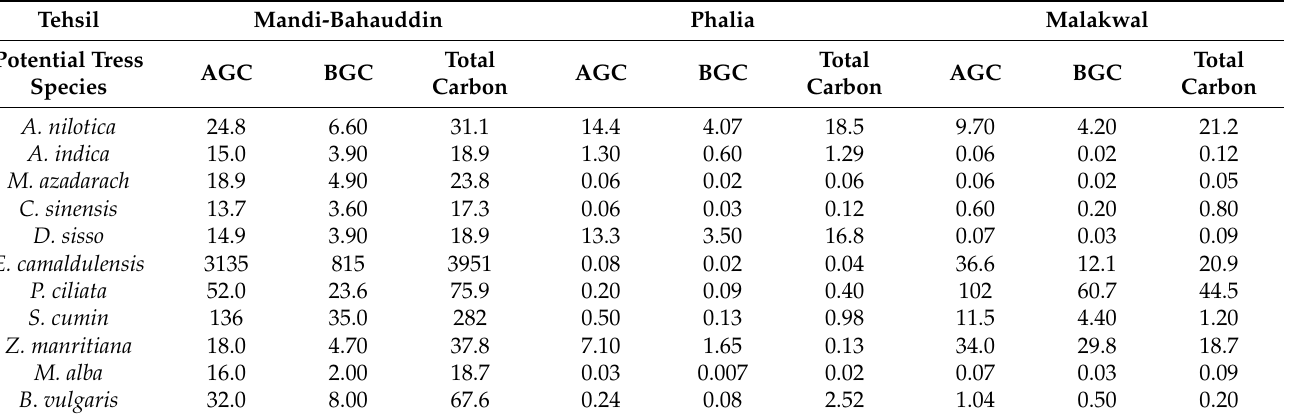
Figure 2. Tree species abundance in Mandi-Bahauddin district ( A ) and tree species distribution expressed as a percentage of total basal area for agroforestry plots in tehsils Mandi-Bahauddin ( B ), Phalia ( C ) and Malakwal ( D ) in Punjab, Pakistan. Table 4. Summary of above ground carbon, below ground carbon and total carbon (Mg C ha − 1 ) of selected species at various points from the brick